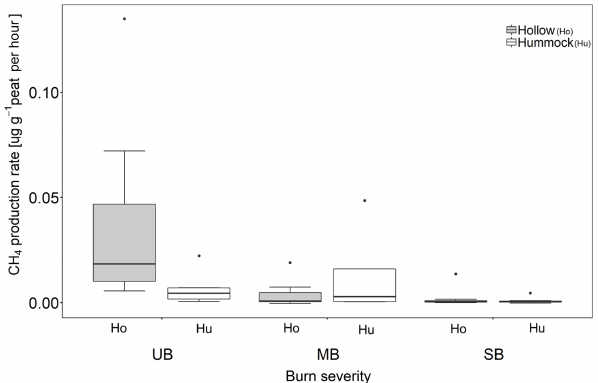
Figure 4. Potential methane (CH 4 ) production across the peat burn severity gradient and microform type. Each microform represents four sample